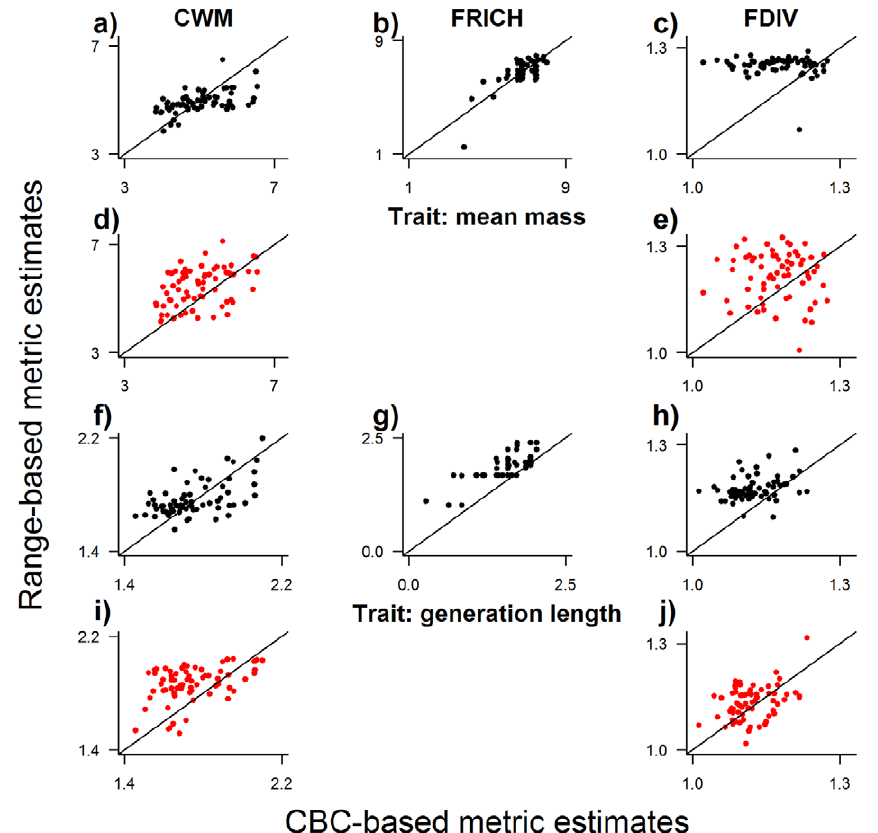
Figure 3. Correlation between distribution-based and CBC-based values of community composition metrics based on continuous traits. For each of the two continuous traits considered – body mass and generation length – maps were generated of community-weighted mean trait value (CWM; a, d, f, i), functional richness (FRICH; b, g) and functional divergence (FDIV; c, e, h, j). Observed values were calculated from recorded abundances at 68 Christmas Bird Count (CBC) evaluation sites. Distribution-based estimates of the metrics were generated using four methods, but only results from the best two methods are presented here: 1) overlaying range maps (black symbols); and 2) overlaying range maps with estimates of species abundance that vary among species and within species’ ranges (red symbols). Abundance was estimated by modelling recorded abundances with respect to three environmental variables using generalized additive models. Lines represent y=x. Full results for all four methods are presented in Table